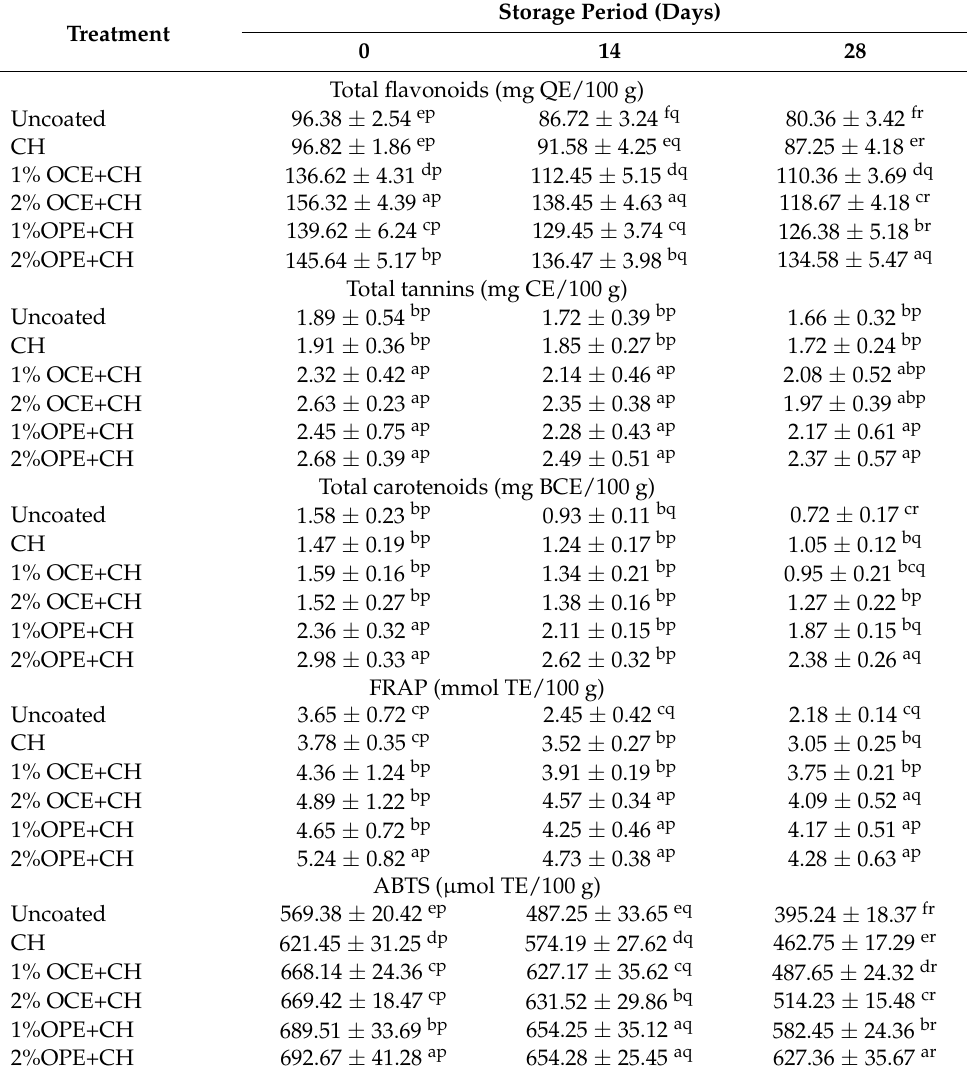
Table 1. Changes in total flavonoids, tannins and total carotenoids in fresh Barhi dates coated with chitosan (CH) and/or olive-cake (OCE) or orange-peel extracts (OPE) during cold storage (4 ◦ C). Storage Period (Days) Treatment 0 14 Total flavonoids (mg QE/100